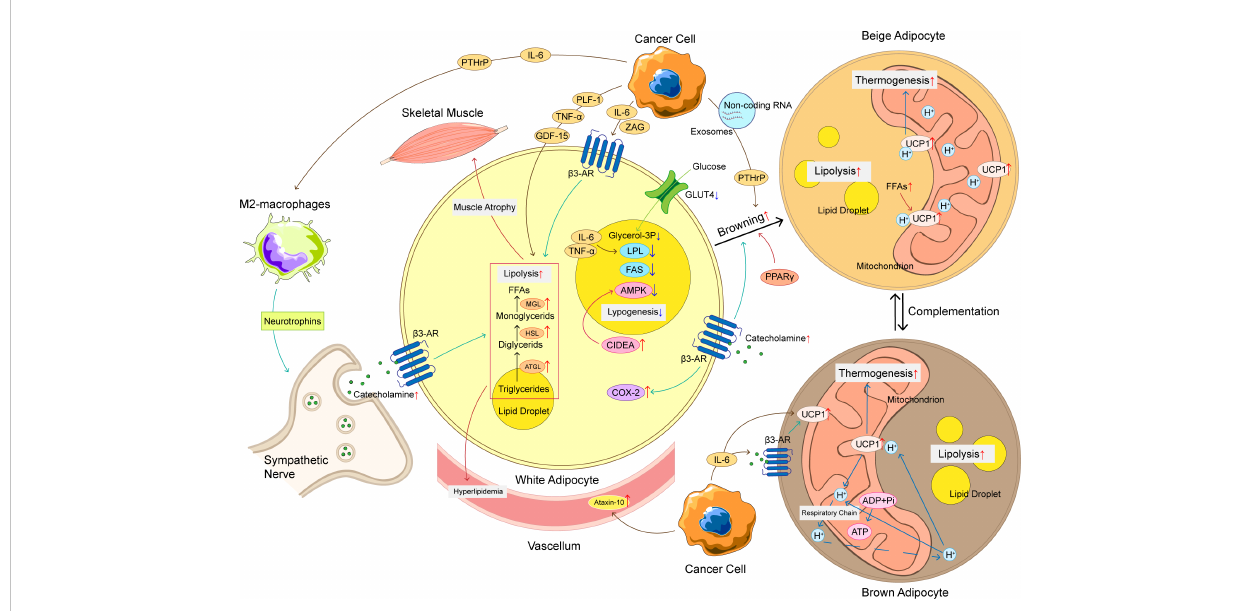
FIGURE 1 The mechanism of adipose tissue loss in CAC. The mechanism of adipose tissue loss in CAC is complicated, and these mechanisms can be roughly divided into increased lipolysis, browning of WAT, increased thermogenesis of BAT, and decreased lipogenesis. Cancer cells produce a variety of cytokines to promote adipose tissue loss, such as IL-6, TNF- a , PTHrP, etc. These cytokines not only promote lipolysis, but also promote WAT browning and upregulation of UCP1 in BAT, ultimately leading to an increase in thermogenesis and energy consumption. At the same time, the crosstalk between adipocyte and immune cells and nervous system also plays an important role in abnormal lipid metabolism of CAC. The loss of adipose tissue has a chain reaction that can produce hyperlipidemia and promote skeletal muscle atrophy, making CAC patients ’ condition worse. CAC, cancer-associated cachexia; WAT, white adipose tissue; BAT, brown adipose tissue; FFAs, free fat acids; ATGL, adipose triglyceride lipase; HSL, hormone-sensitive lipase; MGL, monoglyceride lipase; LPL, lipoprotein lipase; FAS, fatty acid synthase; UCP1, uncoupling protein 1; b 3-AR, adrenoceptor beta 3; ADP, adenosine diphosphate; ATP, adenosine triphosphate; IL-6, interleukin-6; TNF- a , tumor necrosis factor a ; PTHrP, parathyroid hormone related protein; ZAG, zinc- a 2-glycoprotein; PLF-1, proliferin-1; GDF15, growth differentiation factor 15; CIDEA, DNA fragmentation factor like effector A; AMPK, adenosine 5 ’ -monophosphate (AMP)-dependent protein kinase; COX-2, cyclooxygenase 2; GLUT-4, glucose transporter